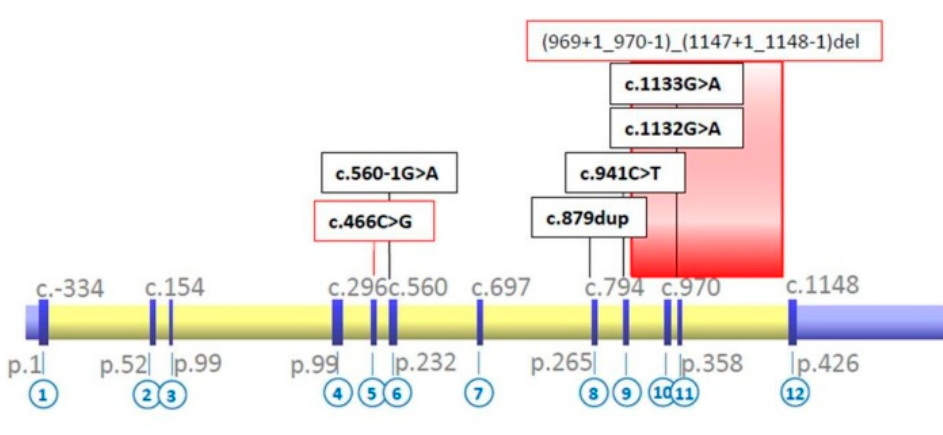
Figure 1. IVD gene structure and localization of identified molecular variants (numbers in the circles refer to exons; novel variant are marked in red).